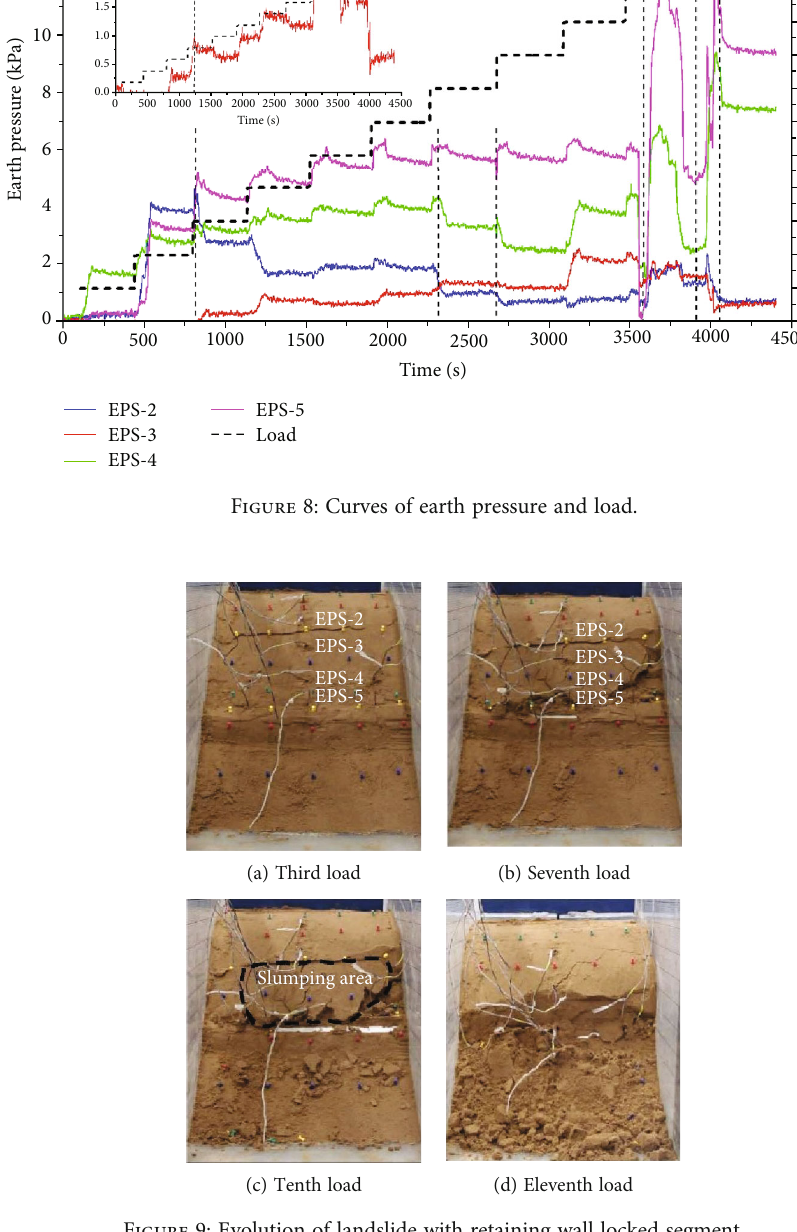
Figure 9: Evolution of landslide with retaining wall locked